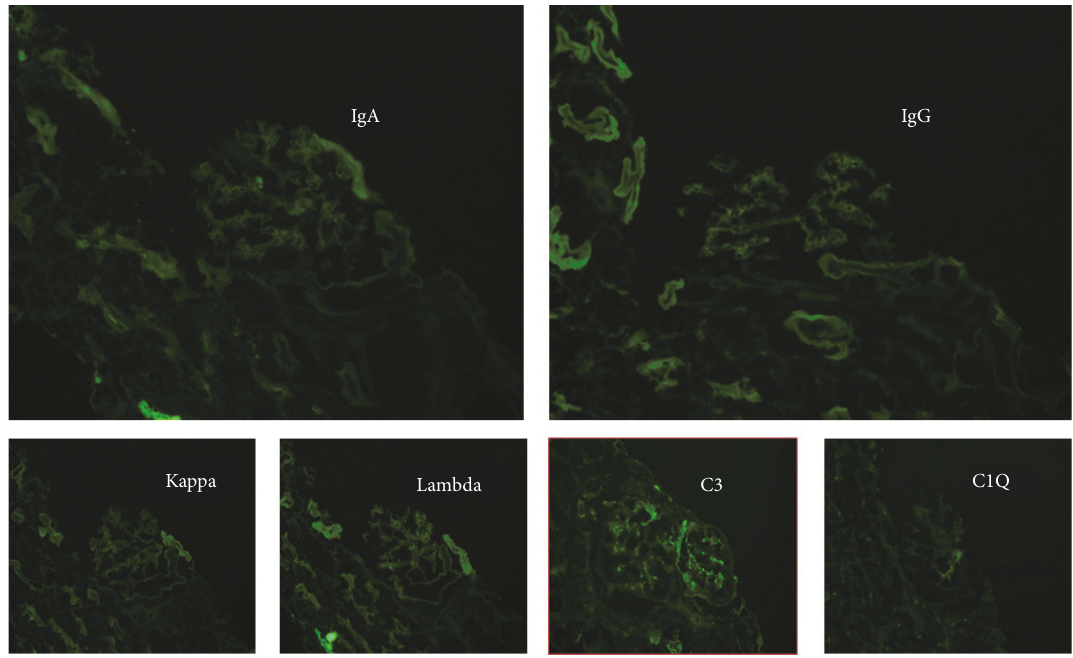
Figure 5: Kidney biopsy immunofluorescence . Immunofluorescence microscopy probing for IgA, IgG, Kappa light chains, Lambda light chains, C3, and C1Q deposits. Trace focal deposition of C3 is present. IgA, IgG, Kappa light chains, Lambda light chains, and C1Q deposits are not